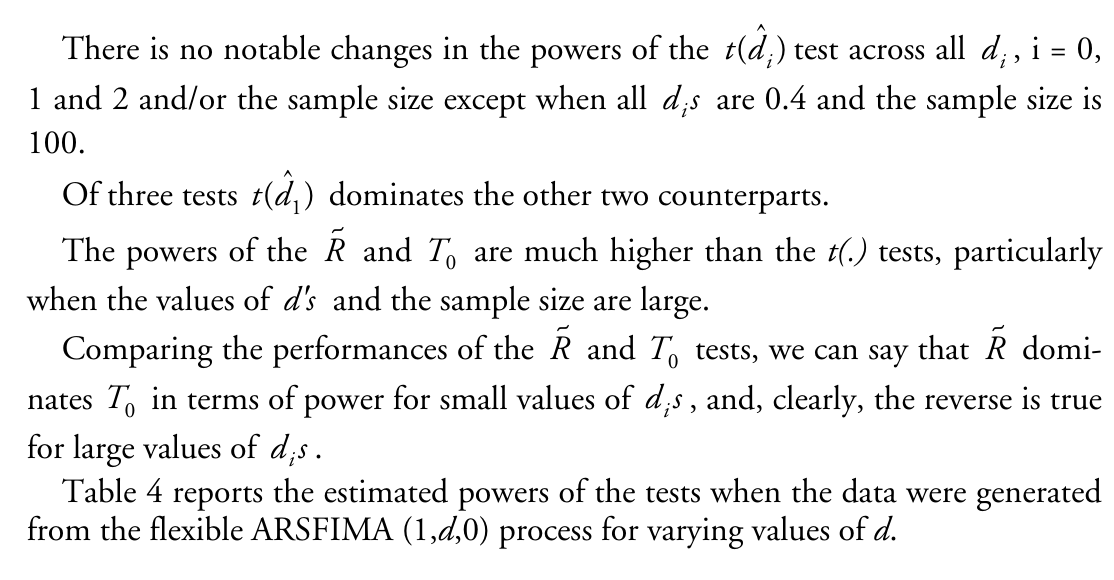
Estimated powers of the seasonal fractional integration tests for testing